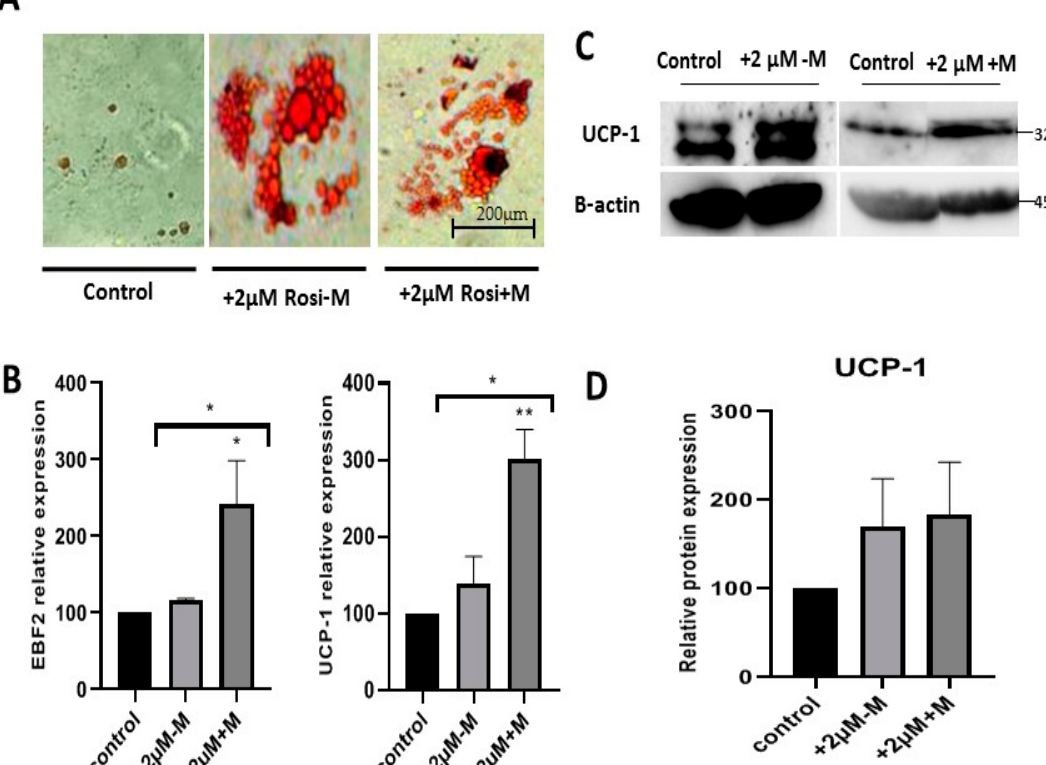
Figure 4. Rosiglitazone induces browning characteristics during adipocytes formation. ( A ) Oil-O red staining of adipocytes with (+) or without ( − ) rosiglitazone. ( B ) Gene expression profiles of EBF2 transcription factor and UCP-1 brown adipocyte marker in control and 2 µ M rosiglitazone treatment in the induction (+2 µ M-M) and rosiglitazone treatment within both induction and maintenance (+2 µ M+M). ( C ) The representative Western blot of brown adipocyte marker, UCP-1, in the differentiated adipocytes without rosiglitazone and with rosiglitazone in the induction only and rosiglitazone in induction and maintenance: UCP-1 (~32 kDa), normalized to that of β -actin (~45 kDa). ( D ) Quantity of the UCP-1 protein level in each condition. The data are presented as mean ± S.E.M. * p < 0.05, ** p < 0.01 versus control.